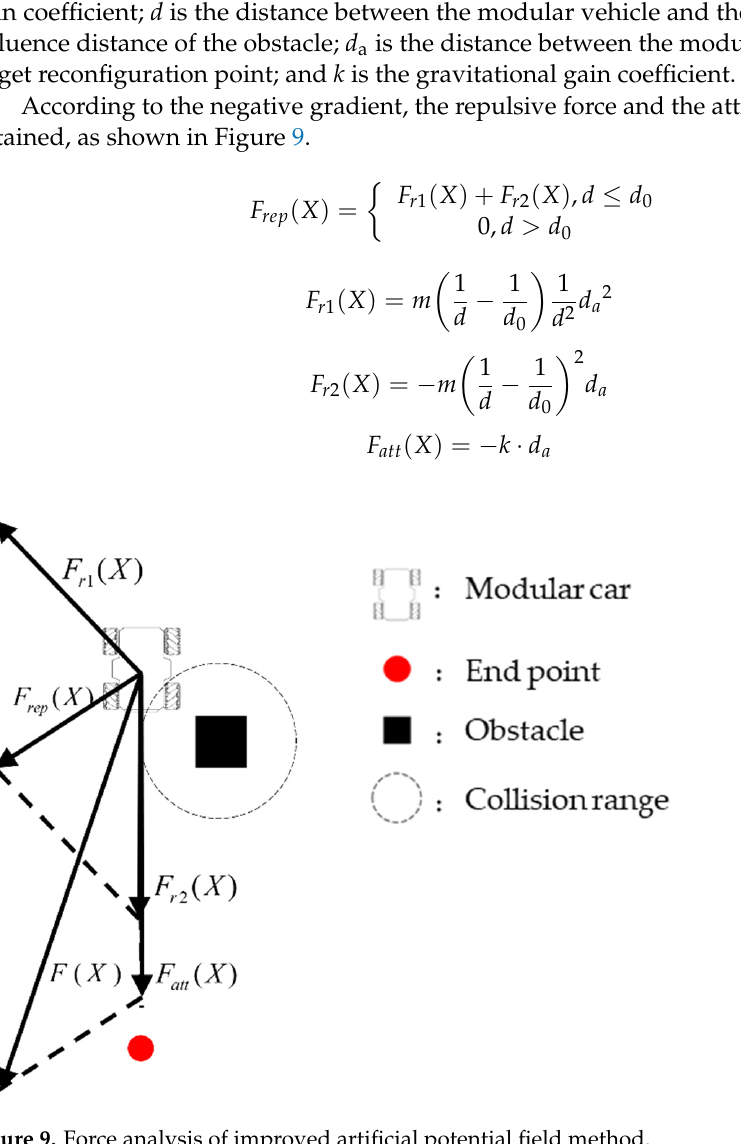
Figure 9. Force analysis of improved artificial potential field method .